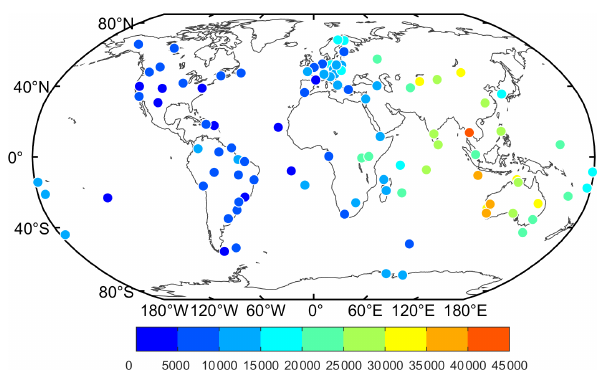
Figure 2. Distribution of average number of available observation epochs for selected MGEX stations in January 2019.